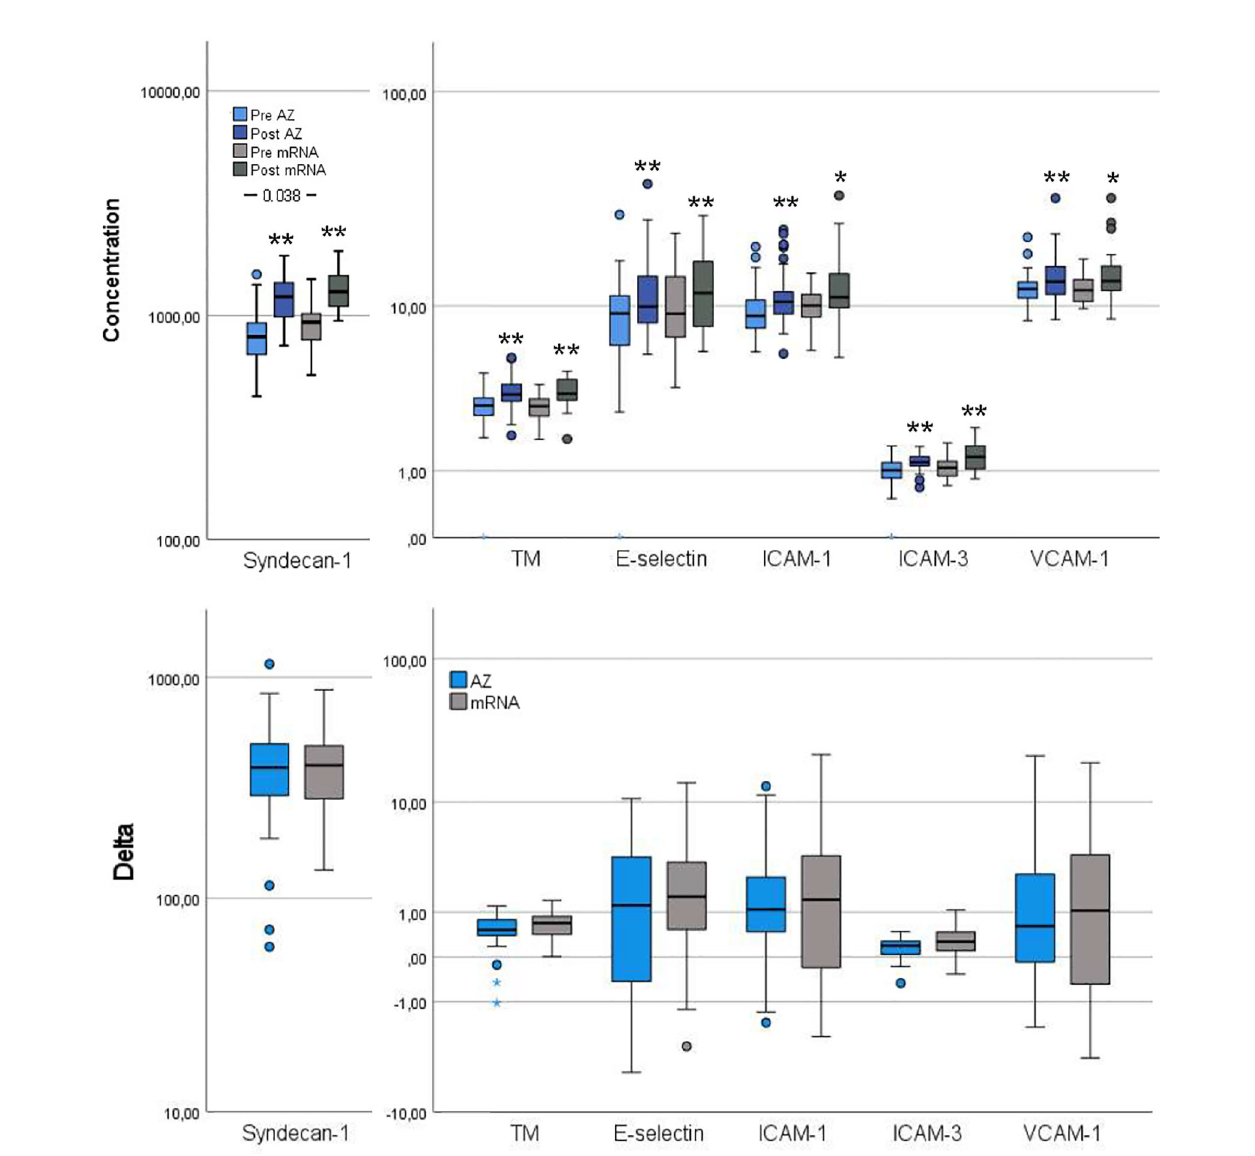
FIGURE 3 | Vascular endothelial activation markers pre- and post-vaccination and delta changes with either AZ (n=55) or mRNA (n=25) vaccines. Levels of Syndecan-1 (pg/ml), thrombomodulin (TM, ng/ml), endothelial (E)-selectin (ng/ml), intercellular adhesion molecule (ICAM)-1 (µg/ml), ICAM-3 (ng/ml) and vascular cell adhesion molecule (VCAM)-1 (µg/ml) are displayed on log scales. The top fi gure displays pre- and post-vaccination values, and the bottom fi gure displays delta changes. The box plots display median, fi rst and third quartile (box mid-line, button and top, respectively) and the whiskers display maximum and minimum values with outliers (circles) and extremes (small asterisks) displayed. AZ vaccinated individuals are displayed by blue bars (top fi gure: pre=light blue, post=dark blue) and mRNA vaccinated individuals are displayed by gray bars (top fi gure: pre=light gray, post=dark gray). Differences between AZ and mRNA vaccinated individuals either pre- and post-vaccination and delta changes are investigated by Mann-Whitney U test, with p-values displayed. Changes over time within the AZ or mRNA groups are investigated by Wilcoxon signed-rank test, with **p < 0.0001 and *p < 0.010 (displayed over the post-vaccination